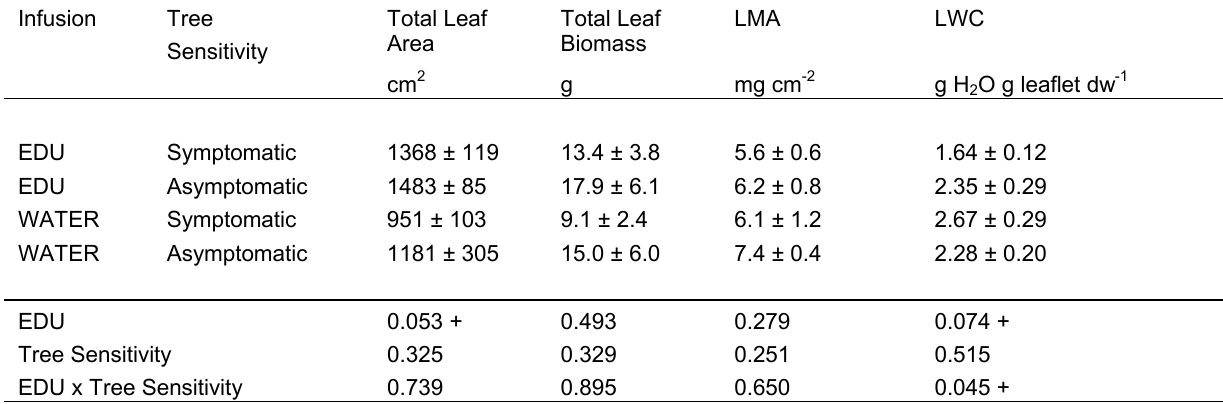
Means (±SE) and Levels of Significance of a Two-Way ANOVA for the Effects of EDU (Water vs. EDU-Infused Trees) and Tree O 3 Sensitivity (Symptomatic vs. Asymptomatic) on: Total Leaf Area and Biomass, Leaflet Mass per Unit Leaflet Area (LMA) and Leaflet Water Content (LWC) in Shoots of Adult Fraxinus excelsior Trees Measured at the End of the Growing